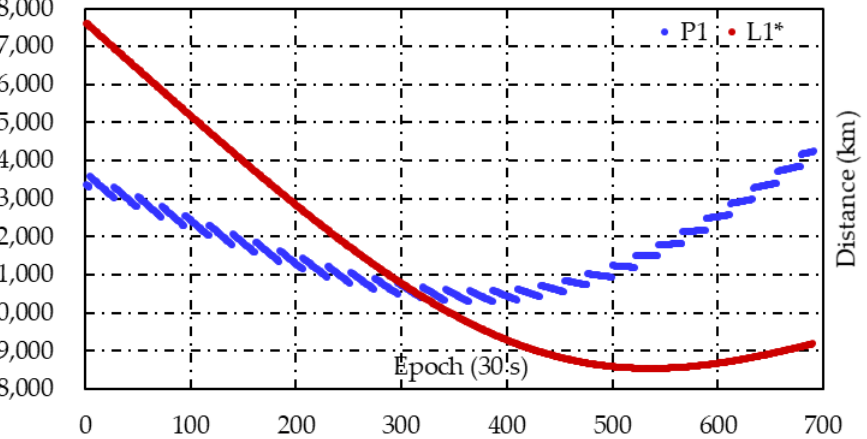
Figure 2. Original P1 and L1 observation time series of G24 on DOY 133, 2008, for PIXI under clock jump of type II.